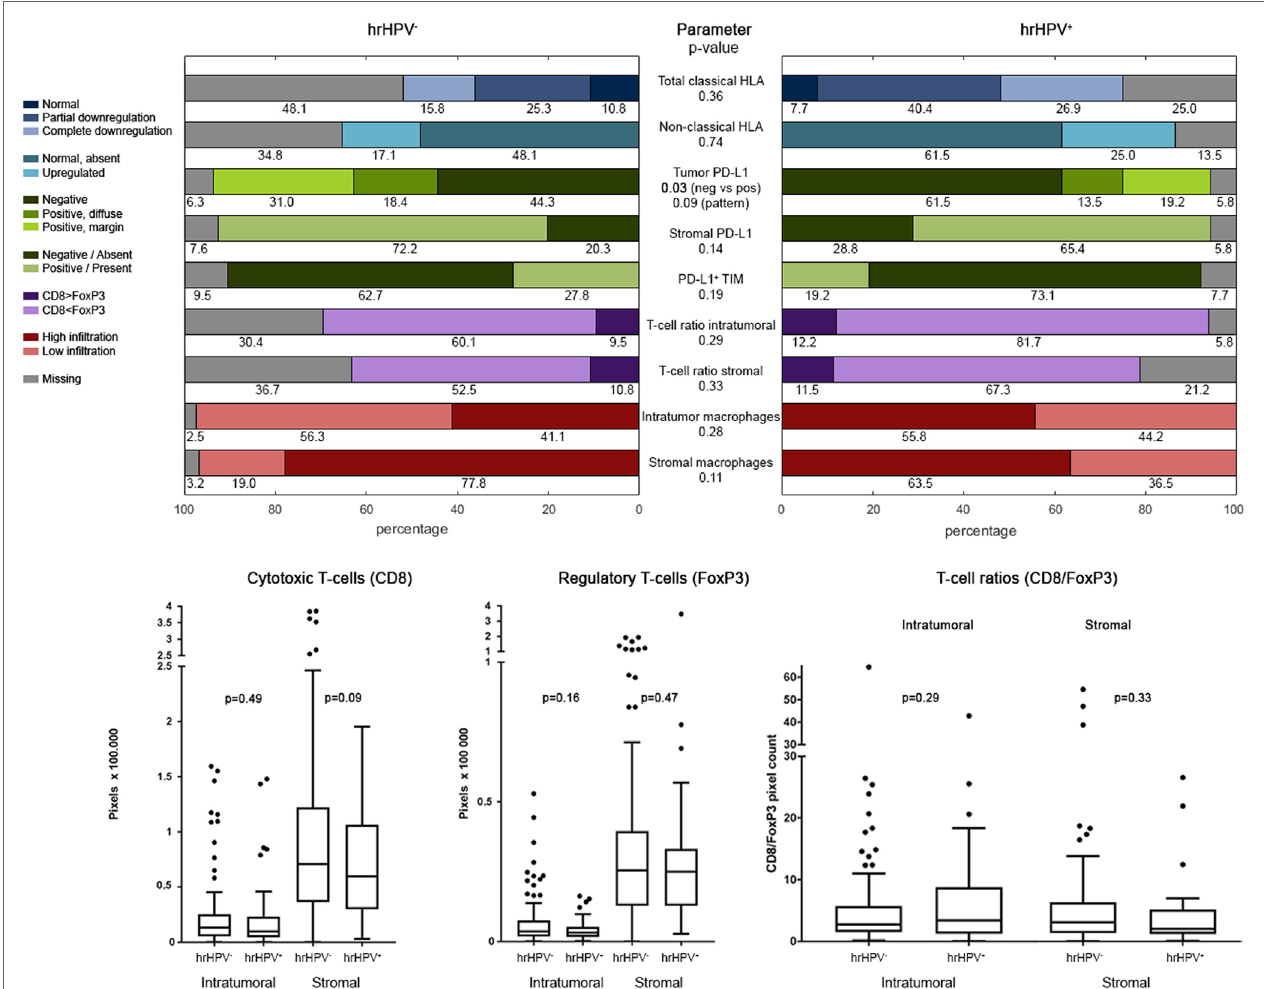
FigUre 2 | Tumor-microenvironmental characteristics. Plots of immune parameters in hrHPV − and hrHPV + samples; categorical variables in bar plots, continuous variables in box plots. p -Values of testing comparable distribution in hrHPV groups. Table S2 in Supplementary Material presents the same data. Abbreviations: HLA, human leukocyte antigen; PD-L1, Programmed death ligand-1; TIM, tumor-infiltrating macrophages; hrHPV, high-risk human papilloma virus. Expression of PD-L1 on tumor cells was compared in two ways: negative vs. positive (neg vs. pos) and negative vs. positive at margin vs. diffusely positive